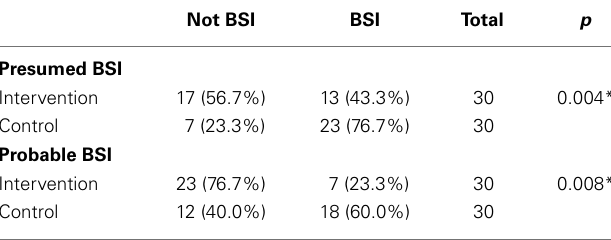
Table 3 | Presumed and probable BSI occurrence in both groups .